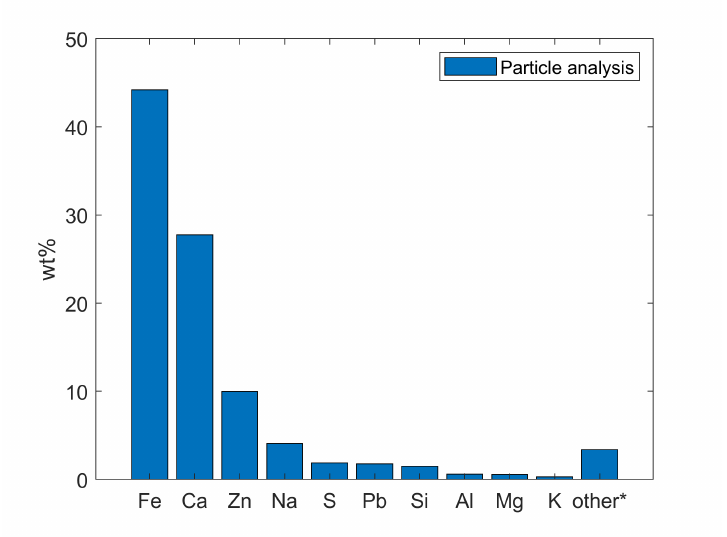
Figure 6. Analysis of brine particles collected in Sønderborg 1-A. Other* indicate the sum of titanium (Ti), phosphorus (P), manganese (Mn), chromium (Cr), barium (Ba), strontium (Sr), nickel (Ni), cobalt (Co), copper (Cu), arsenic (As), and molybdenum (Mo).